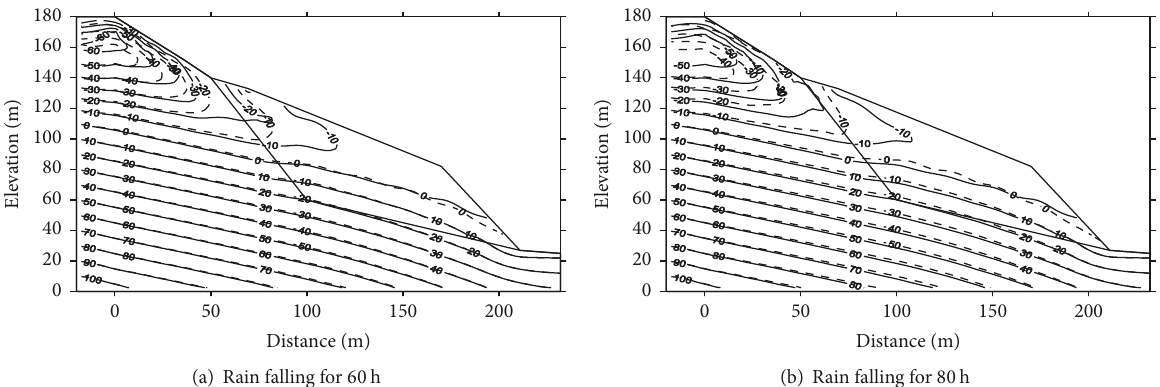
Figure 11: Pressure head for coupling (dashed line) and uncoupling (solid line) (8mm/h).